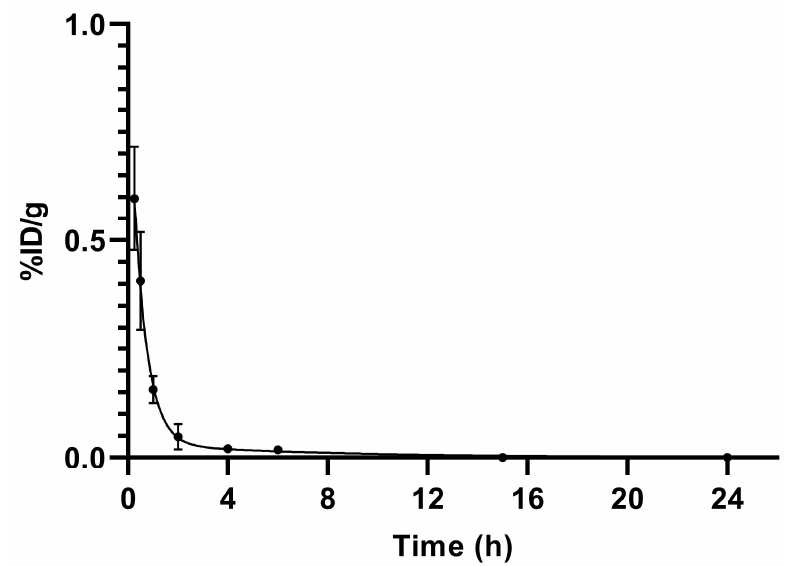
Figure 5. Blood elimination of [ 99m Tc]Tc-PSMA-T4 ( n = 5) in healthy male Wistar rats. Data presented as a mean and standard deviation.